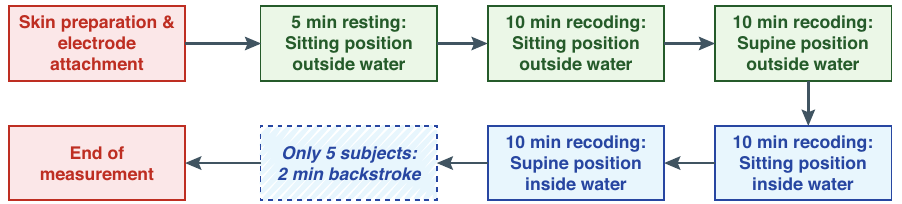
Figure 6. Study procedure for each subject.